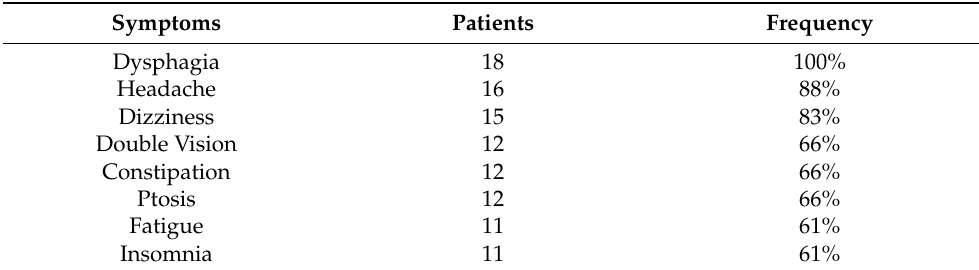
Table 1. Presenting symptoms of patients with foodborne botulism.